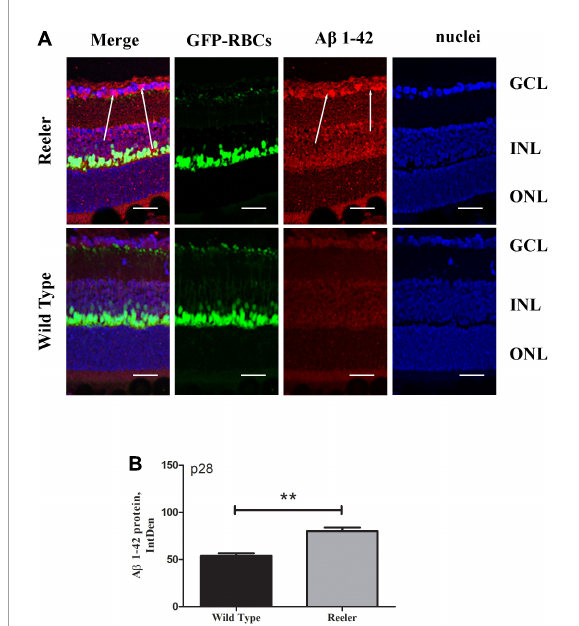
FIGURE2 Retinal expression of A β 1-42 increase in Reeler p28 mice. (A) Immunofluorescent images for A β 1-42 (red), GFP (green), and nuclei (blue) in retina of p28 mice. White arrows point to a noticeable staining of A β 1-42 (red) at the GCL of Reeler retinas. (B) IntDen of A β 1-42 -positive cells was assessed ( n = 3 optic fields per slide of 3 animals per group; ** p < 0.01, Kruskal Wallis analysis with post Dunn’s multiple comparison test analysis). Note the increased expression of A β 1-42 oligomers (mean ± SEM) in Reeler mice with respect to WT. A β 1-42, Amyloid β Protein Fragment 1-42; GFP, Green Fluorescent Protein; GCL, Ganglion Cell Layer; INL, Inner Nuclear Layer; ONL, Outer Nuclear Layer; IntDen, Integrated Optical Densitometry. Magnifications: × 40; white bar: 20 µ